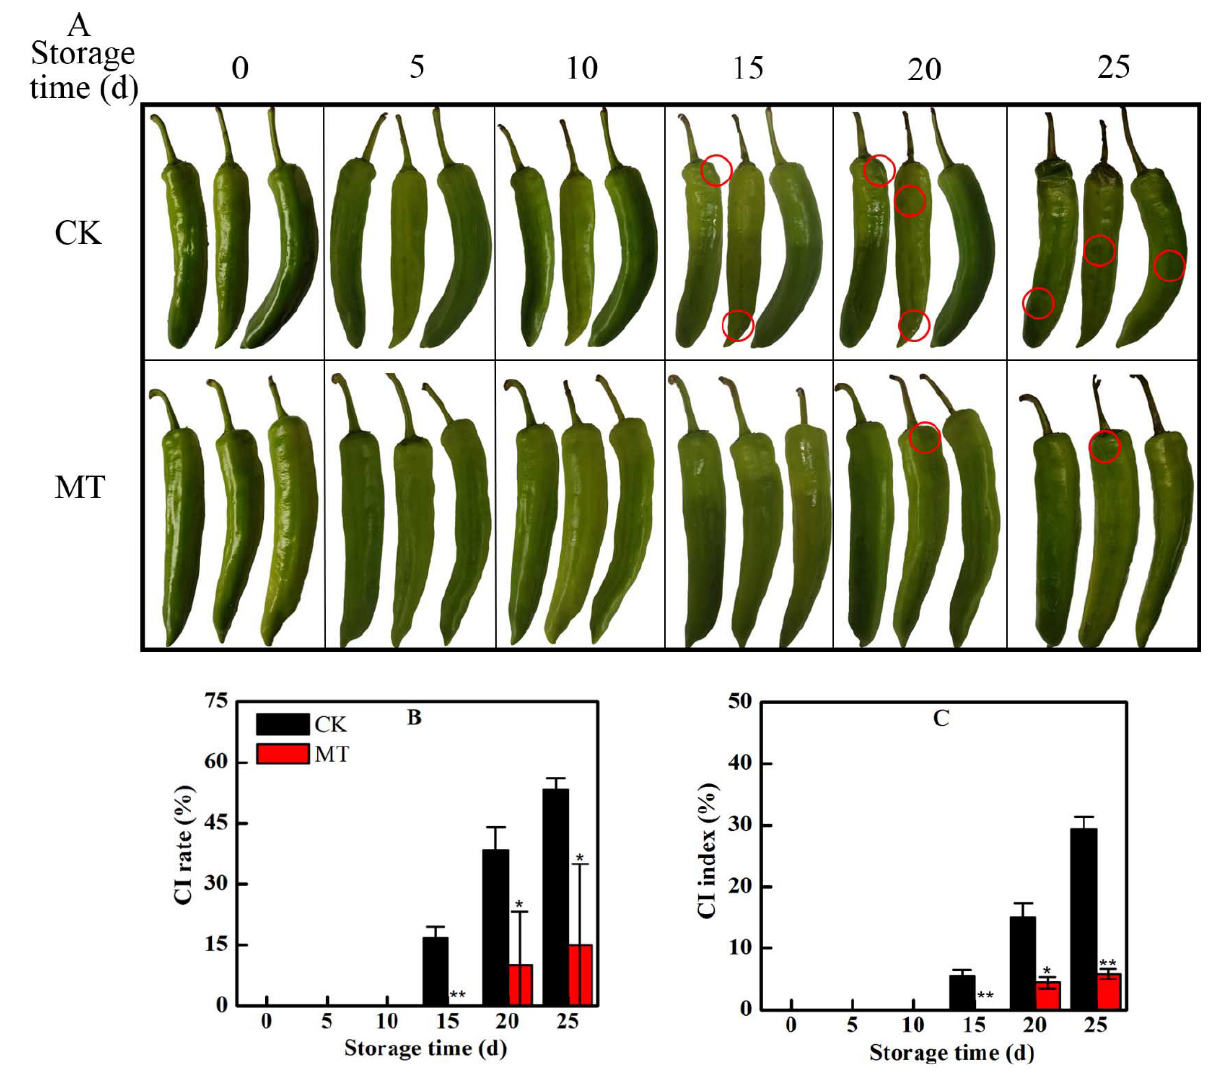
Figure 1. Change in the surface appearance due to chilling injury (CI) ( A ), CI rate ( B ), and CI index ( C ) of horn pepper fruit treated with water (CK) or melatonin (MT). Positions in which the CI symptoms appear on the surface of the pepper fruit are circled in red. Asterisks * and ** indicate the significant differences ( p < 0.05 or p < 0.01, respectively) between treatments.